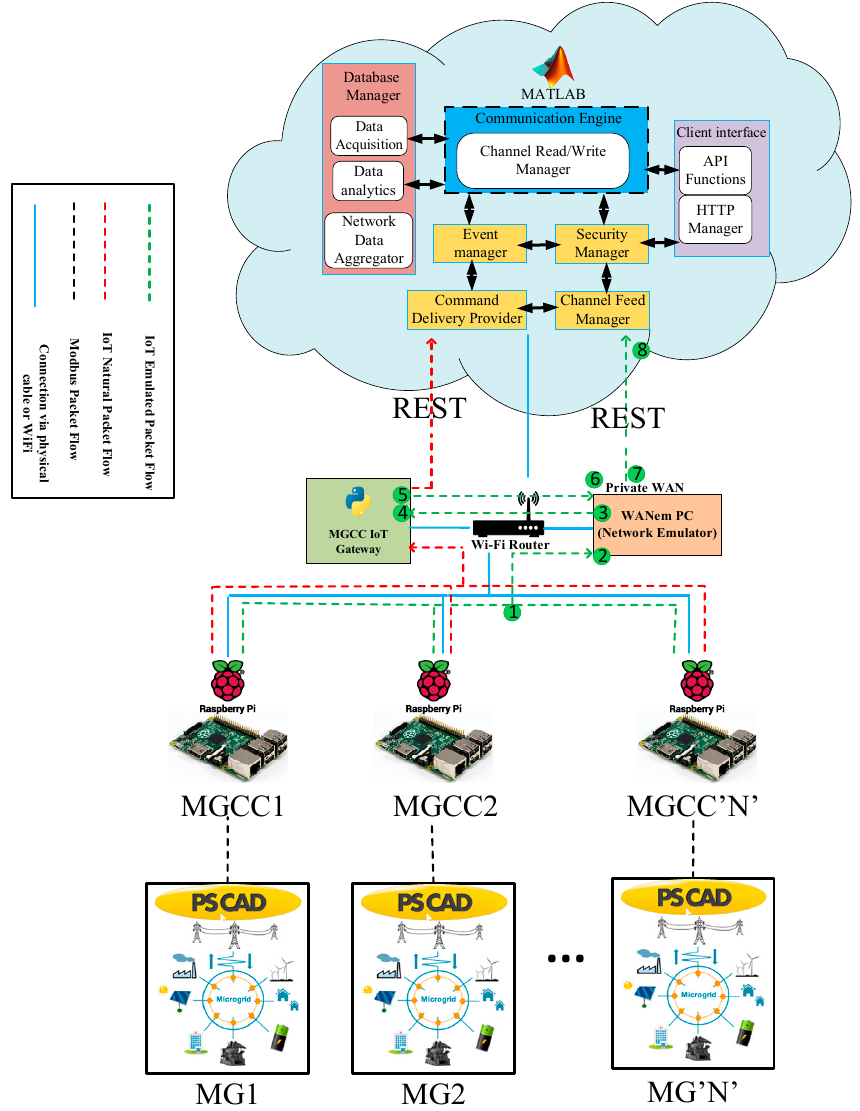
Figure 5. Overview of the cloud-based MMG communication platform.